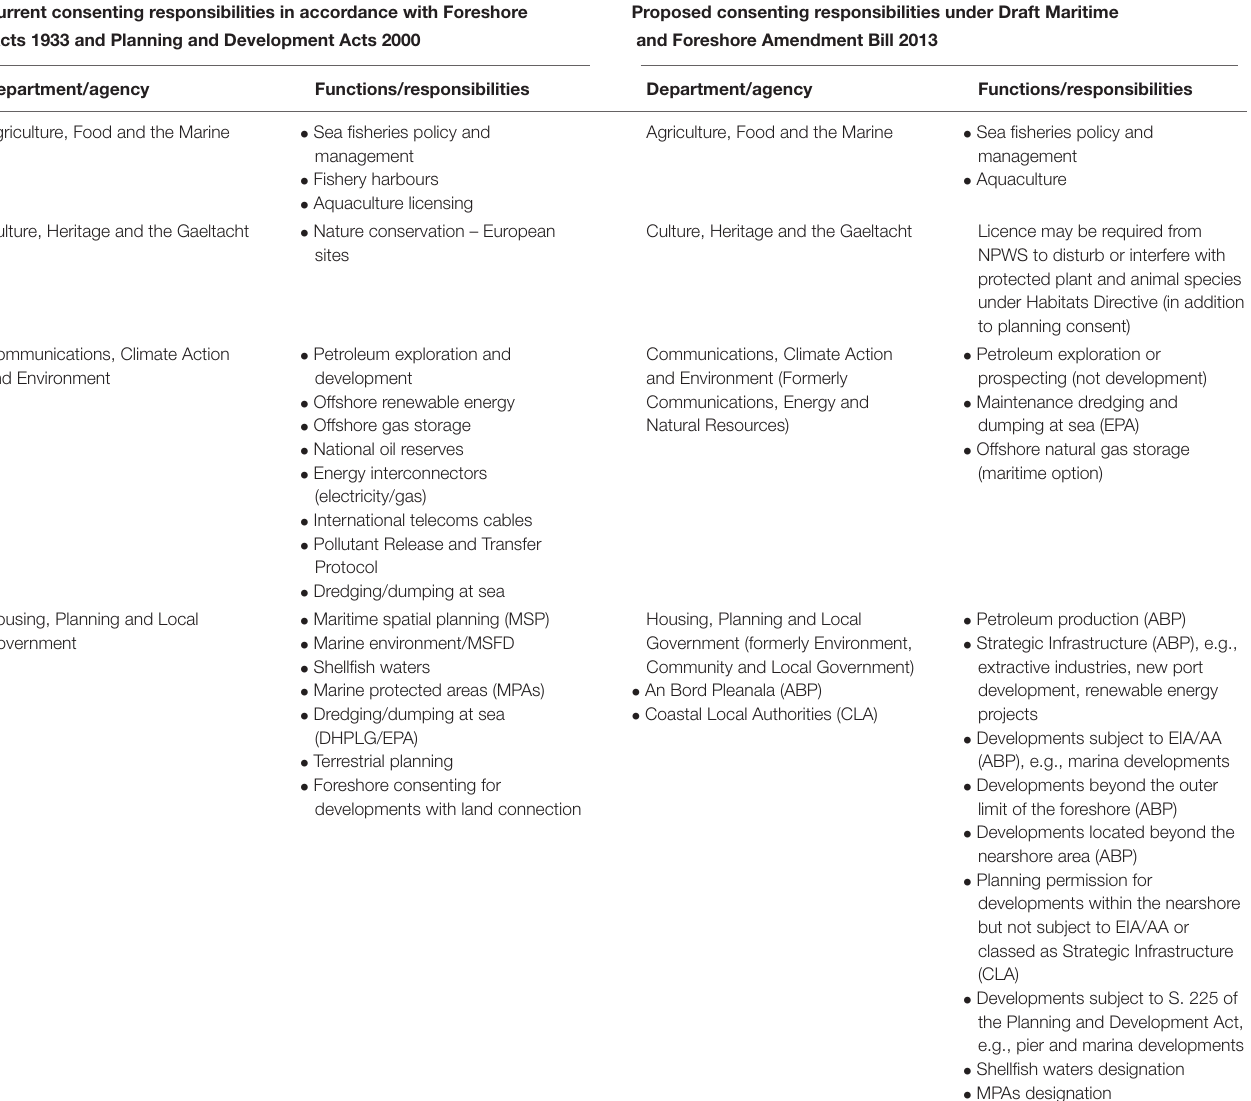
TABLE 2 | Overview of current and proposed marine consents and licensing arrangements in Ireland. Current consenting responsibilities in accordance with